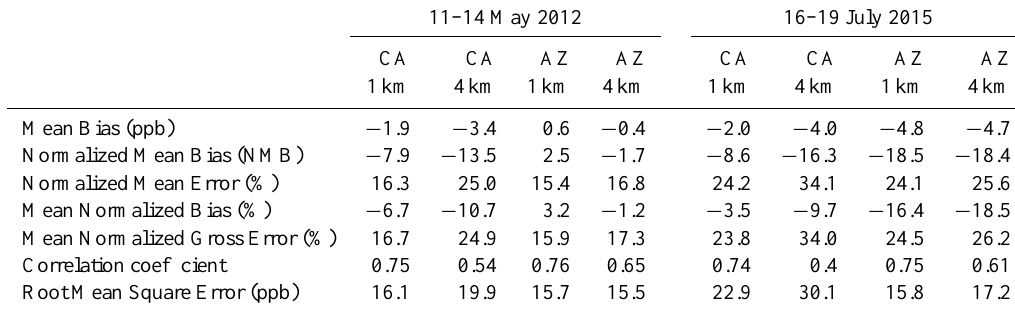
Table 1. Statistical results of hourly ozone concentrations of WRF-Chem simulations (CTRL) at 1 and 4km